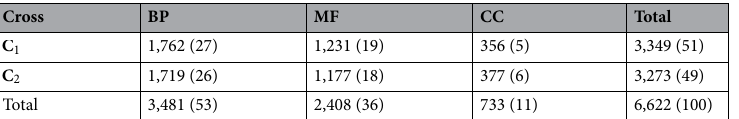
Table 3. Number of GO terms significant at 10% FDR in aspects “Biological Process” (BP), “Molecular Function” (MF) and “Cell Component” (CC). Values inside parenthesis are approximated percentages of the